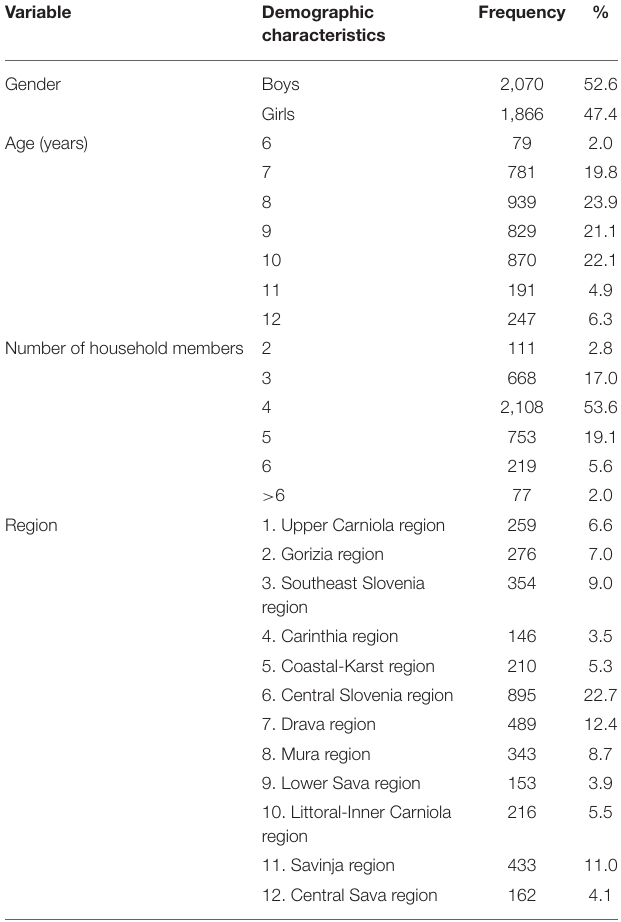
TABLE 1 | Demographic characteristics of the participants. Variable